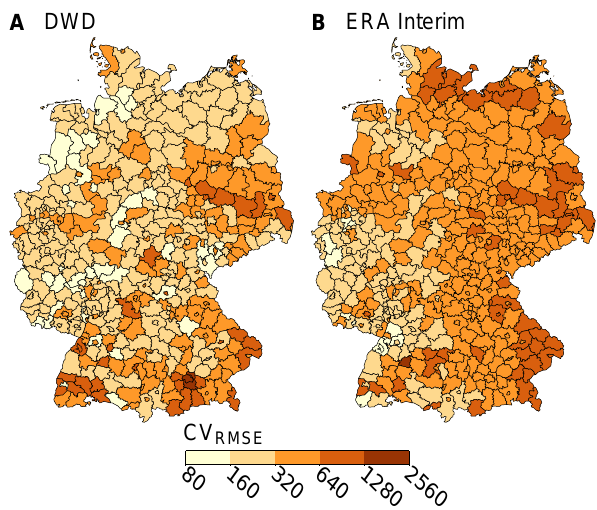
Figure 3. Coefficients of variation of the root mean squared error per district, evaluated for the entire 11-year modelling period. De- picted is the minimum value of CV RMSE found for any of the four models. (a) and (b) show results obtained from DWD and ERA- Interim wind gust data, respectively.